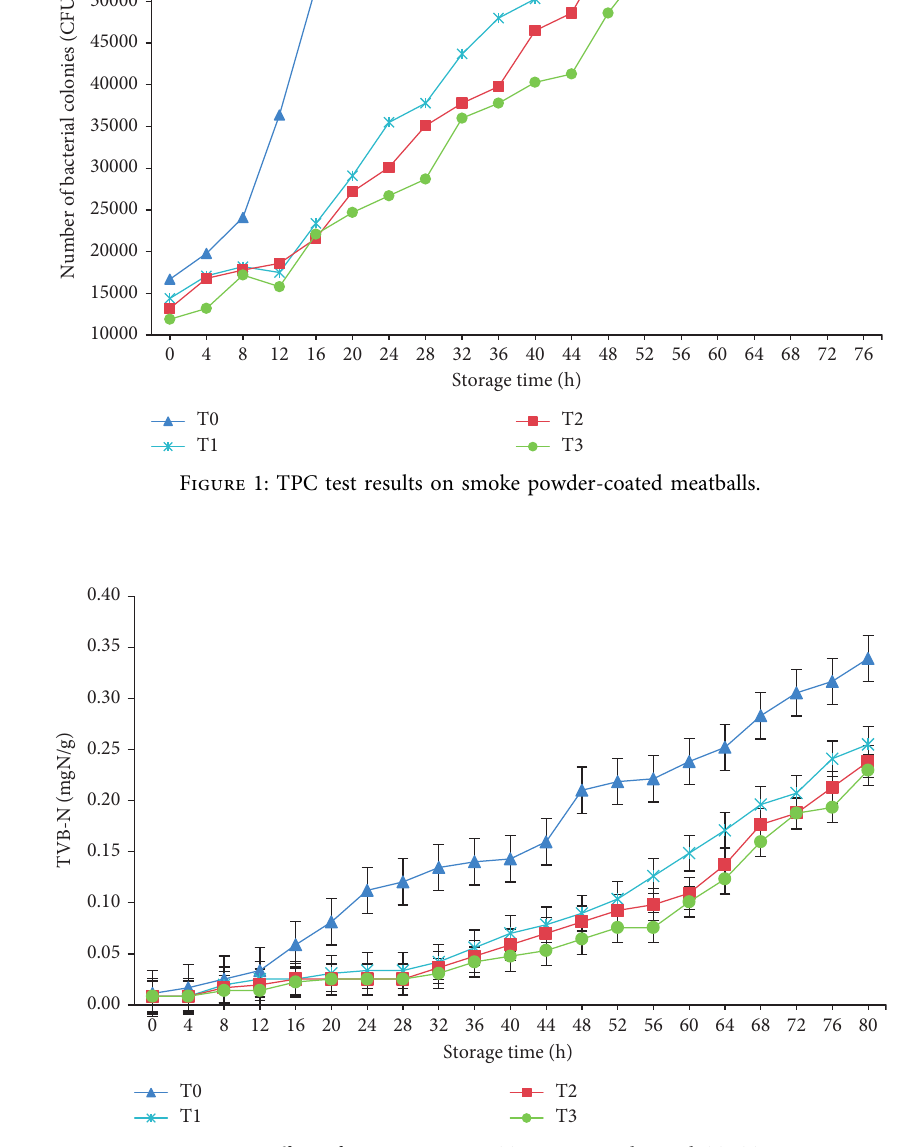
Figure 2: Effect of storage time on TVB on samples with